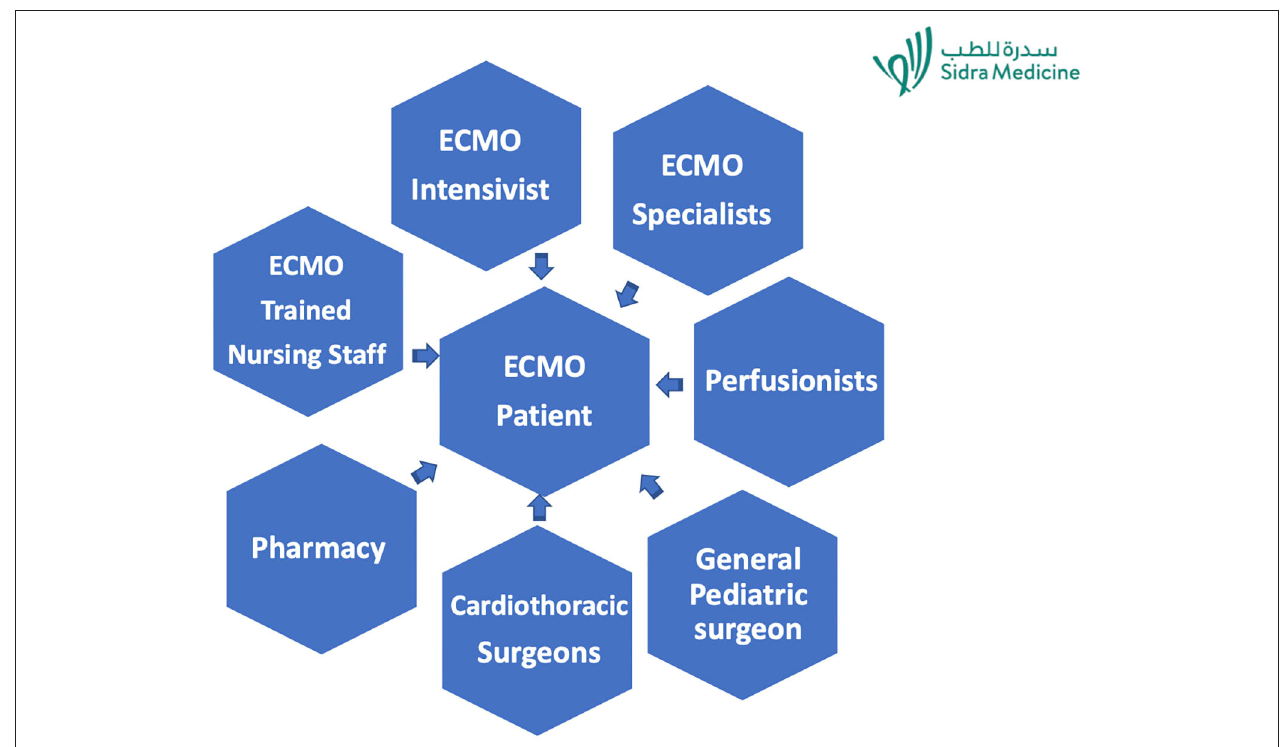
FIGURE 2 | ECMO care